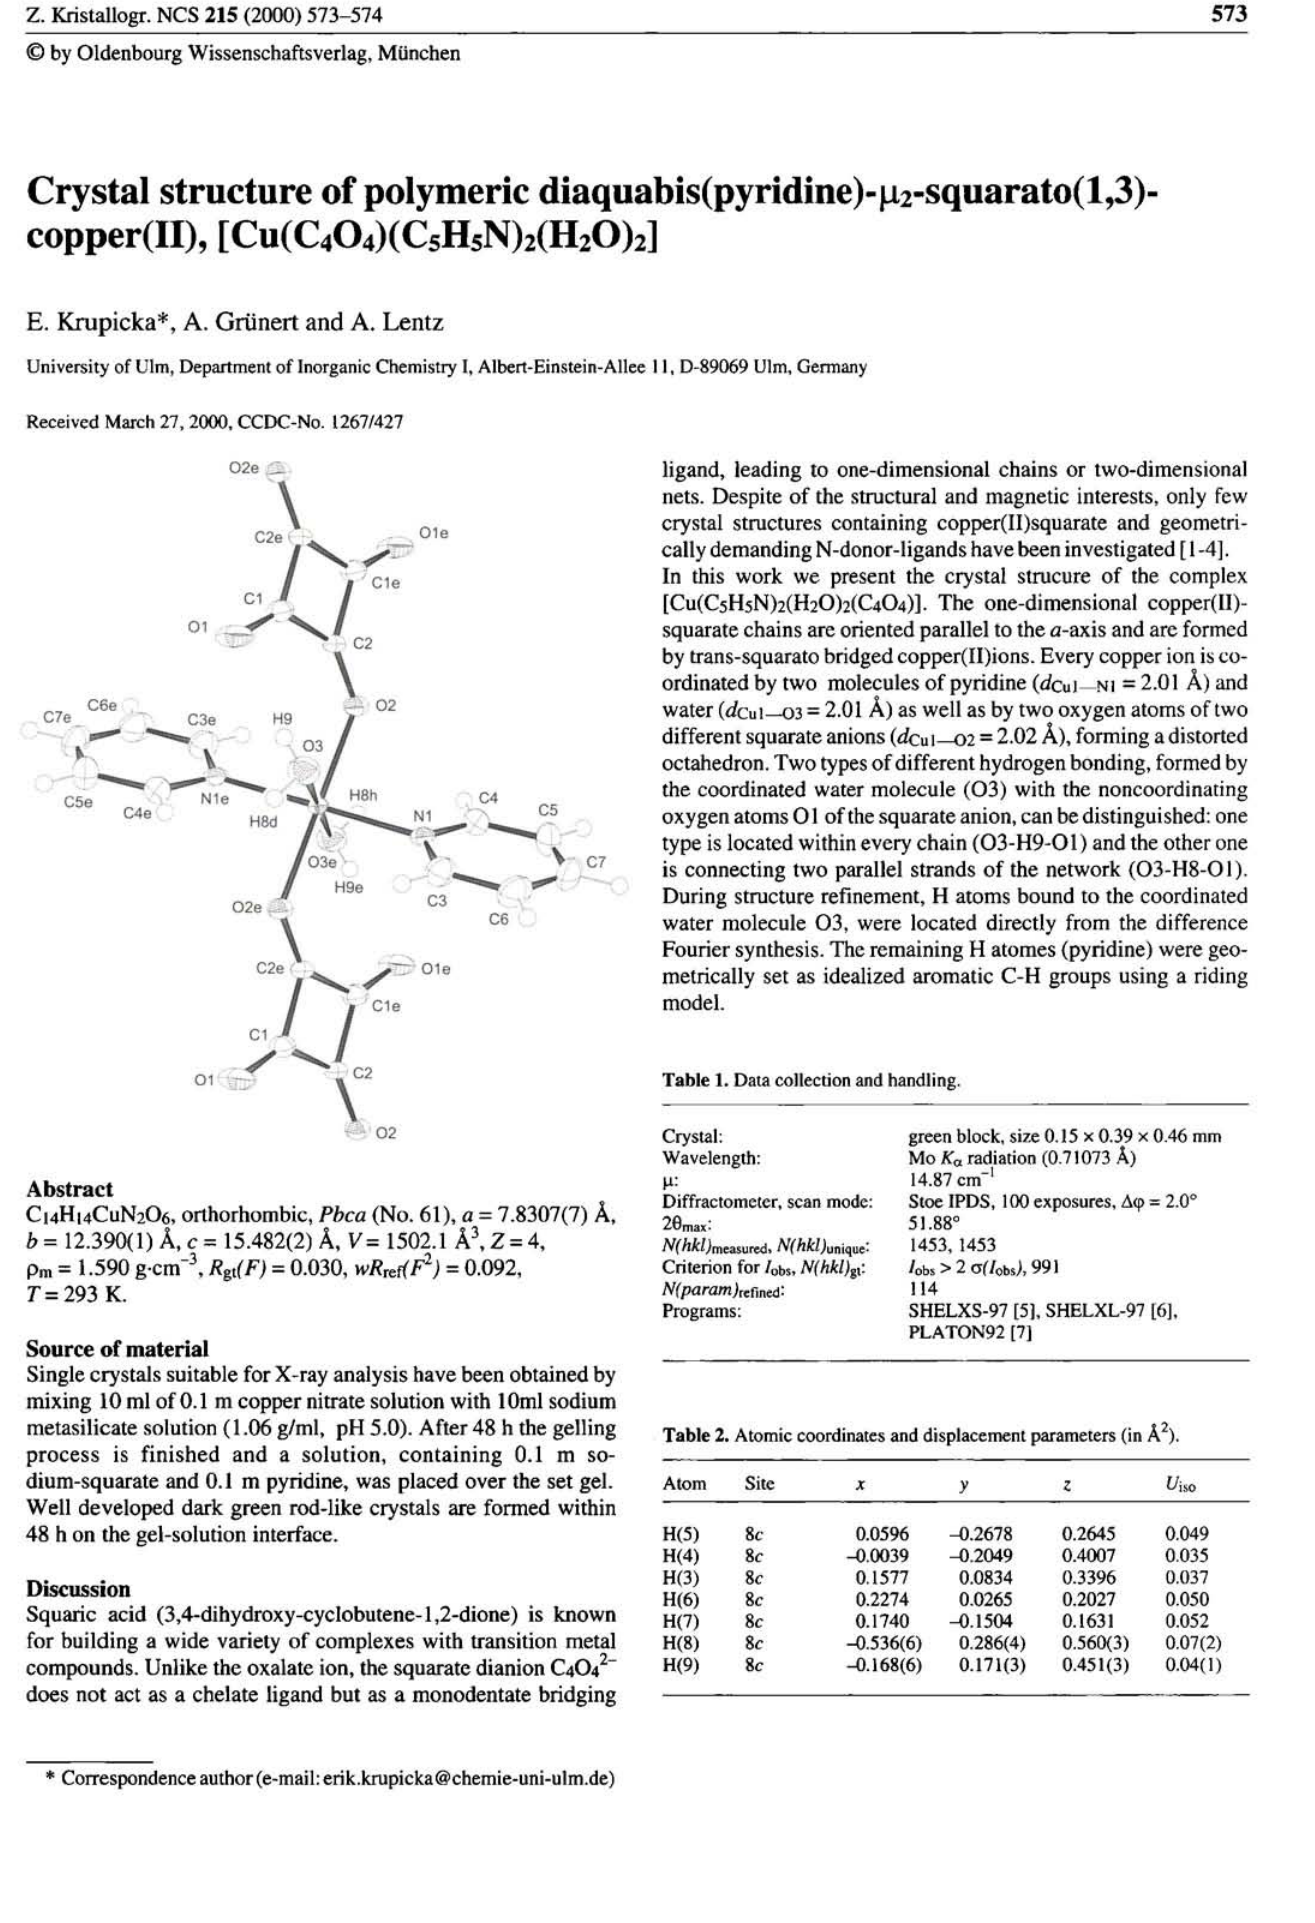
Table 2. Atomic coordinates and displacement parameters (in Â 2